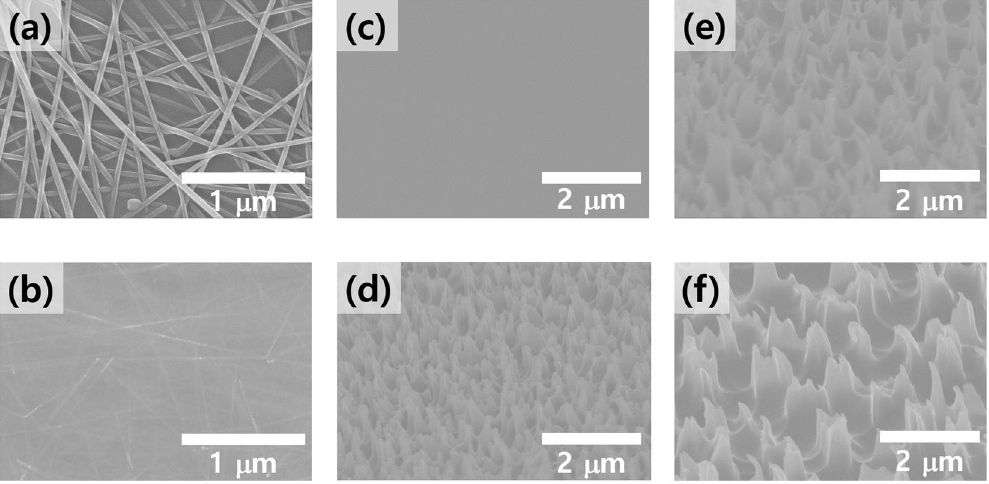
Figure 2. SEM images of ( a ) AgNW networks formed on glass and ( b ) AgNW networks embedded in PVB. SEM images of various PVB/AgNW on glass substrates formed by SF 6 and O 2 plasma treatment. Duration of SF 6 /O 2 plasma treatment was altered to create different RNCs: ( c ) 0 s, ( d ) 300 s, ( e ) 500 s, and ( f ) 700 s. Conditions of the other processes remained